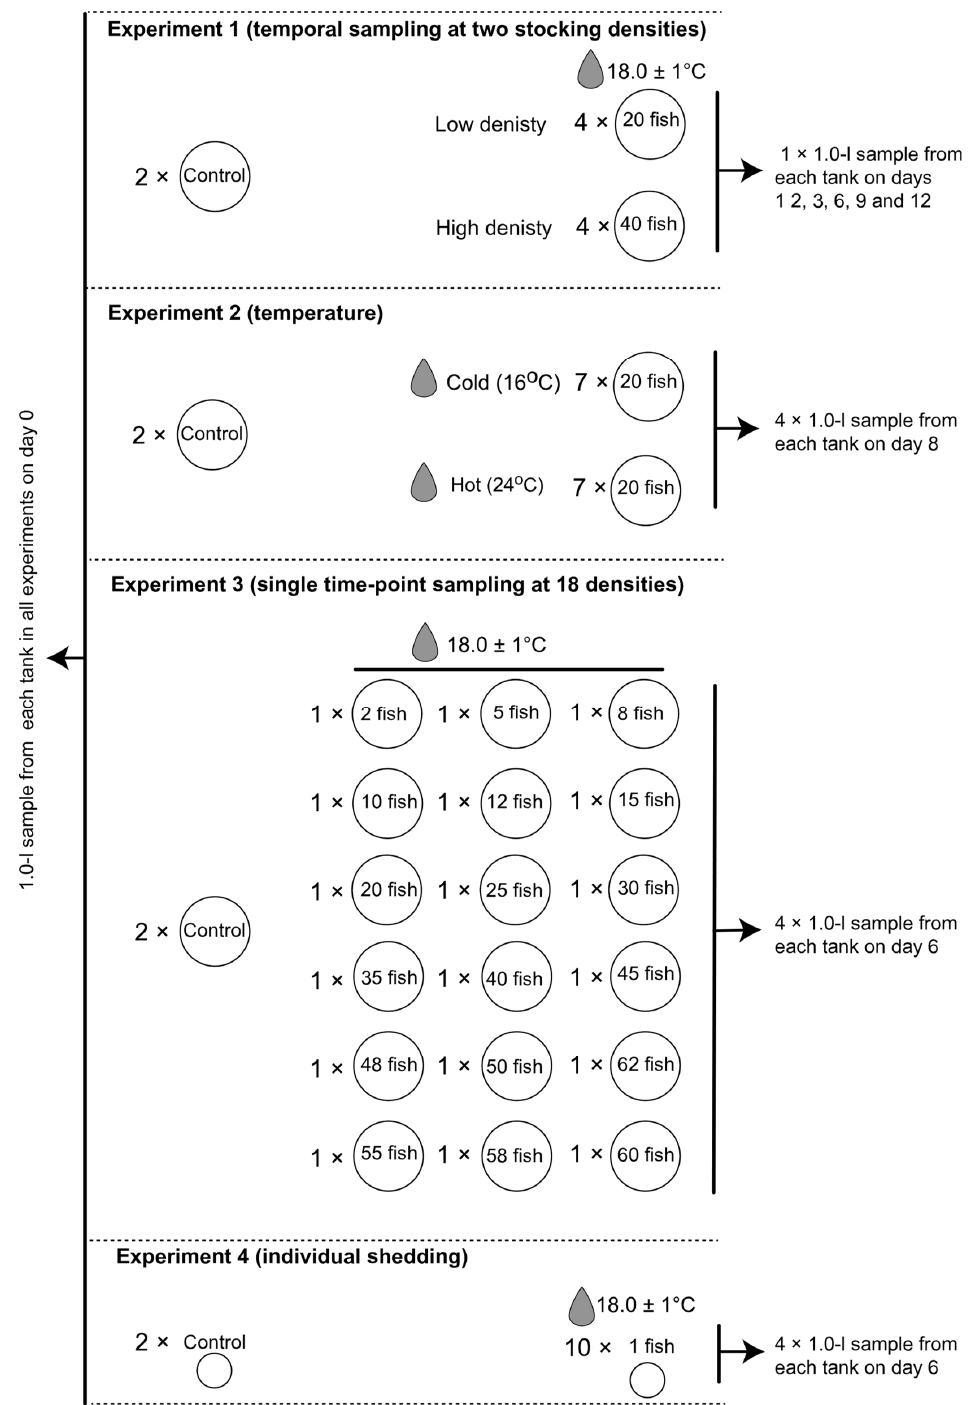
Figure 1. Schematic representation of the four experiments completed at the Port Stephens Fisheries Institute New South Wales, Australia during May to August 2021 to quantify relationships between mulloway, Argyrosomus japonicus eDNA concentrations and their weights across the range of their typical thermal tolerances and schooling densities. The replicate experimental tanks used for con ‐ trols (left) and treatments (right) with stocking densities of mulloway and temporal water sampling for eDNA indicated.